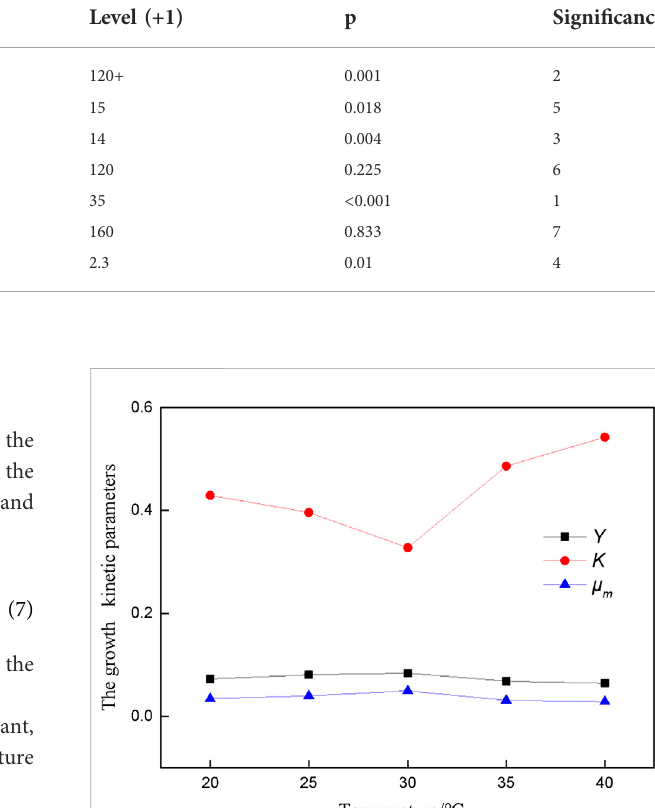
TABLE 4 Analysis of plackett-Burman test